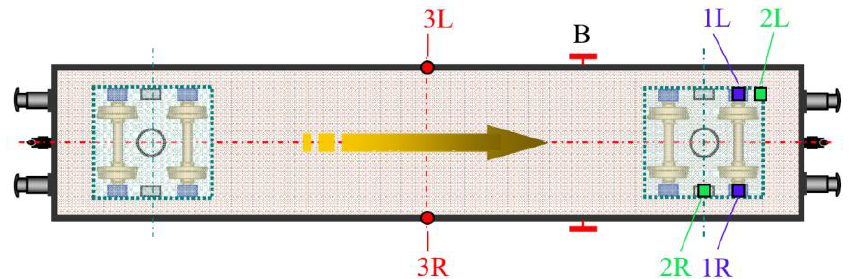
Figure 9. Location of relative vertical deflection and vertical acceleration sensors at selected points. B—handbrake, 1L/R—chassis frame vertical deflection sensor, first wheelset, left/right side, 2L/R—chassis frame and body vertical deflection sensor, left/right side, 3L/R—car body vertical acceleration sensor, left/right side.